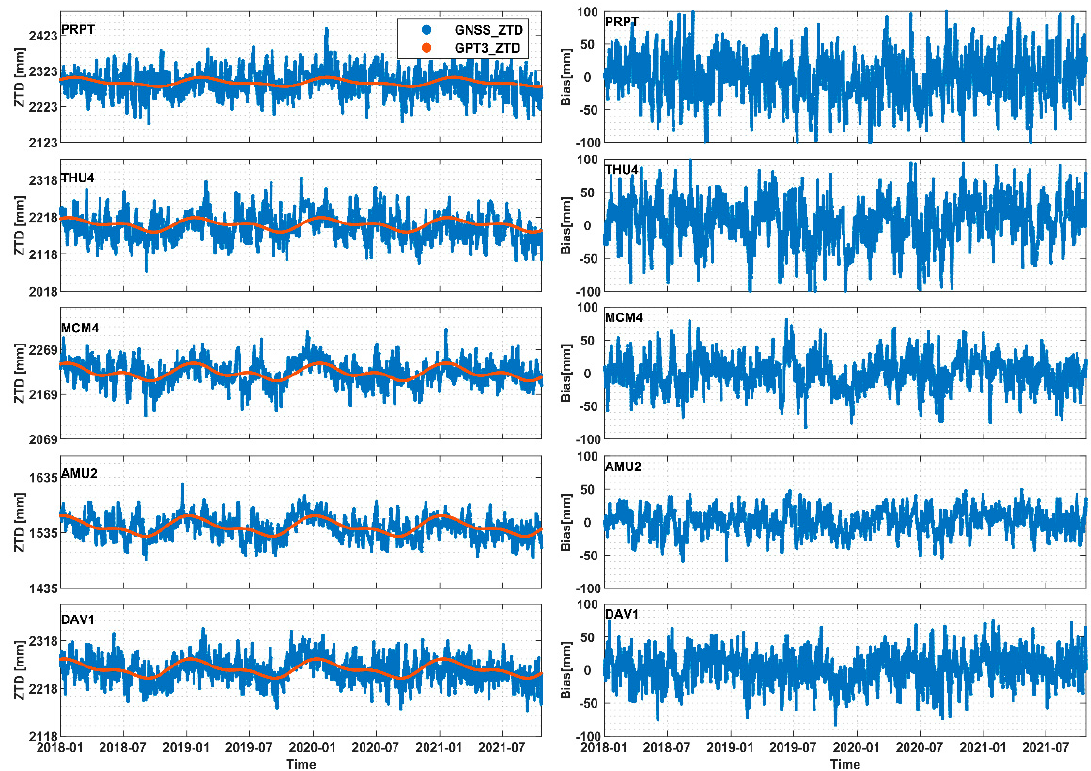
Figure 4. GNSS_ZTD, GPT3_ZTD, and bias of GPT3_ZTD and GNSS_ZTD from 1 January 2018 to 23 October 2021 at PRPT, THU4, MCM4, AMU2 and DAV1 station.